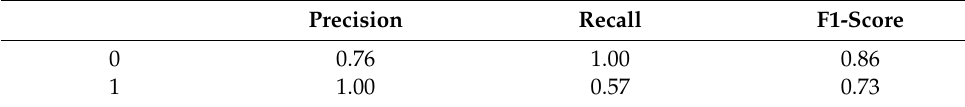
Table 8. Performance Metrics for Training Data.